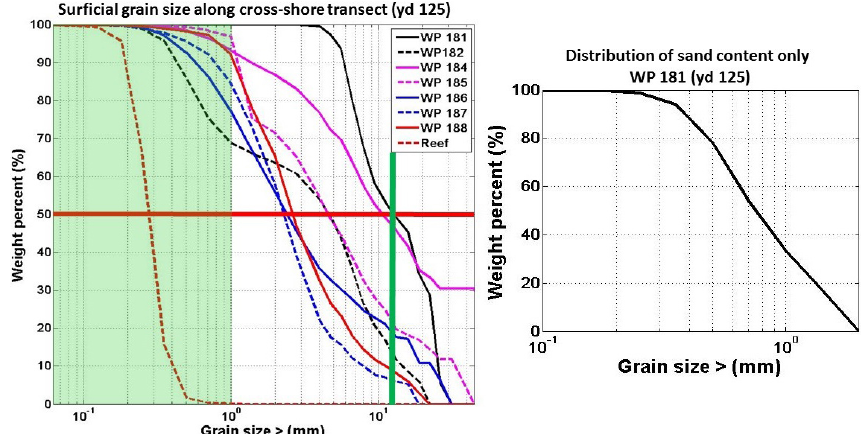
Figure 3. Left panel: representative grain size distributions for beach surface samples collected along a cross-shore profile with position WP 188 being the low tide level and WP 181 at the berm on year day 125. The green bars indicate the grain size range which has been tested in the laboratory shear tests. The red bar indicates the 50% mark at which median grain size d 50 is determined. Right panel: representative distribution of grain size of sand fraction only ( < 2mm) extracted from the sample taken at position WP 181 on year day 125. This sample has been tested in the direct shear box.